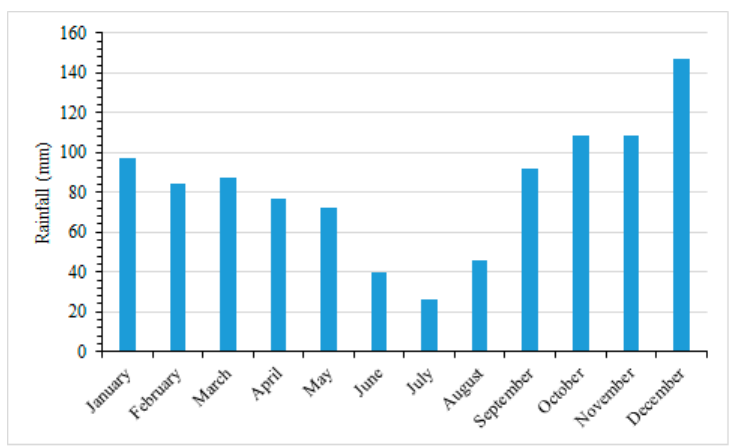
Figure 2. Location of the study area and landslide inventorying.